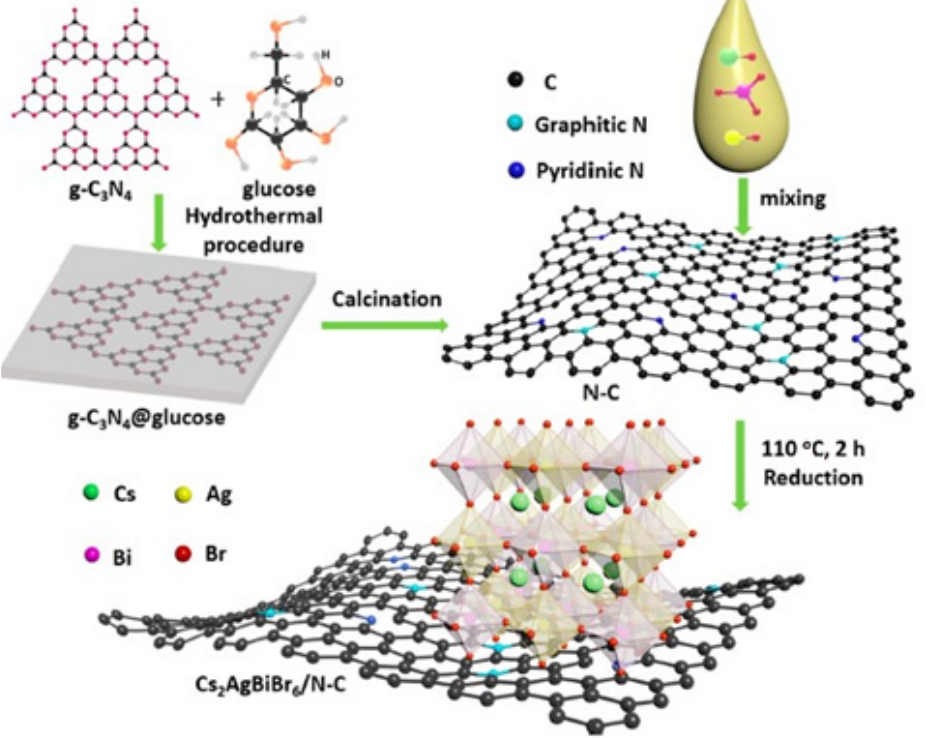
Figure 11. Preparation procedure of Cs 2 AgBiBr 6 /N-C photocatalyst. Reprinted with permission from ref [40]: Copyright 2021, American Chemical Society [40].